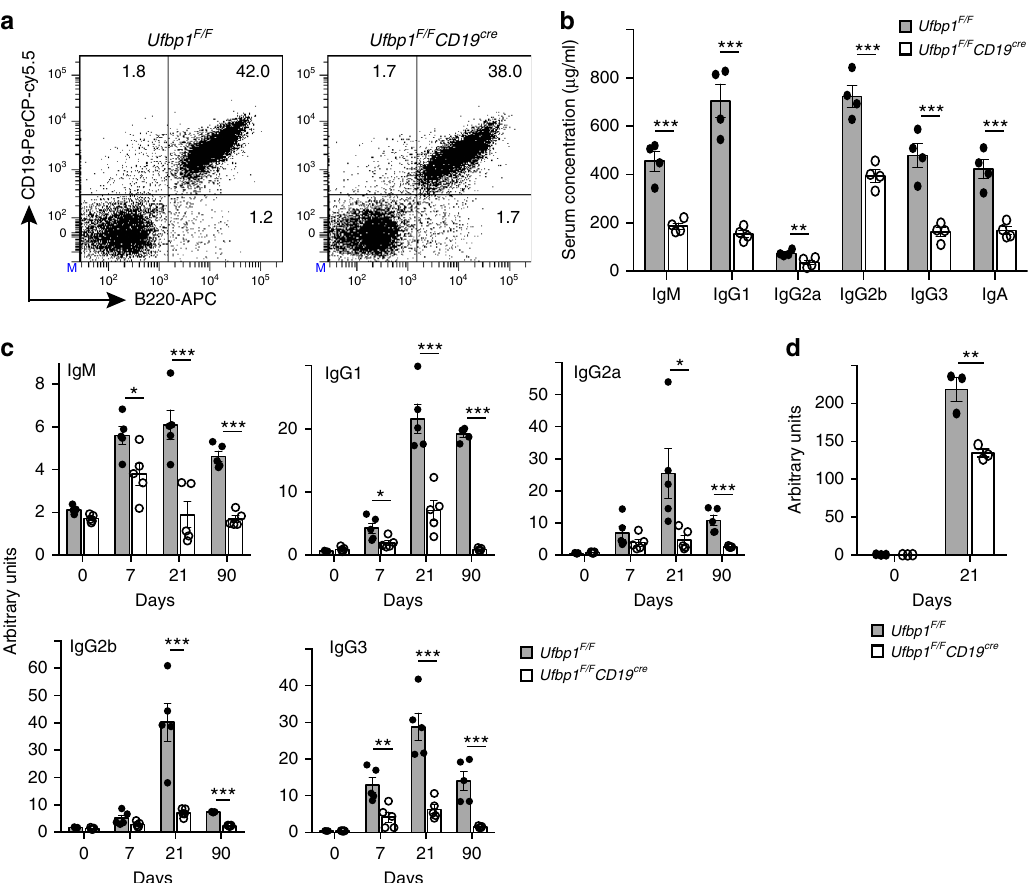
Fig. 1 Defective humoral response in Ufbp1 F/F CD19 cre mice. a Flow cytometric detection of B220- and CD19-positive cells in spleens of indicated mice. Numbers represent the percent positive cells in the corresponding quadrant. b Presence of indicated immunoglobulin isotypes in the serum of indicated mice was quanti fi ed using enzyme-linked immunosorbent assay (ELISA) ( n = 4 mice/genotype). c Six-week-old Ufbp1 F/F and Ufbp1 F/F CD19 cre mice were immunized with 4-hydroxy-3-nitrophenylacetyl conjugated to keyhole limpet hemocyanin (NP-KLH; 100 µ g/mouse, intraperitoneally) in alum. NP-speci fi c antibodies of IgM, IgG1, IgG2a, IgG2b, and IgG3 isotypes in the sera of the mice at indicated time points after immunization were quanti fi ed using ELISA ( n = 5 mice/genotype). Samples were normalized against day 14 sera obtained from wild-type mice immunized with NP-KLH. d Ufbp1 F/F and Ufbp1 F/ F CD19 cre mice were immunized with NP-Ficoll (25 µ g/mouse) intraperitoneally in phosphate-buffered saline. NP-speci fi c antibody of IgG3 isotype in the sera of mice at indicated time points after immunization was quanti fi ed as above ( n = 3 mice/genotype). Error bars represent mean ± standard error. * P < 0.05, ** P < 0.01, *** P < 0.001. Unpaired Student ’ s two-tailed t -test was used. A representative of at least two experiments is